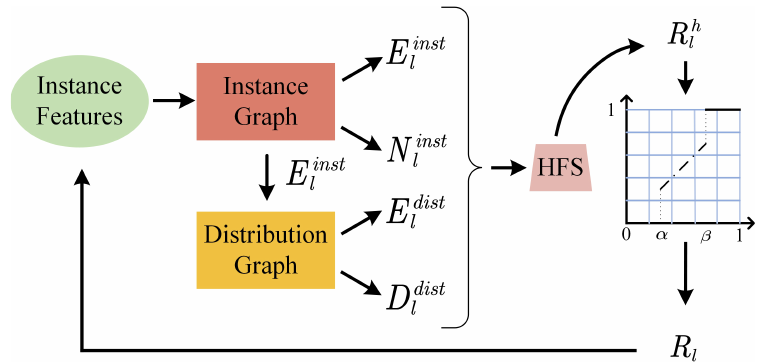
Figure 2. The process of multi-attribute relation transfer in